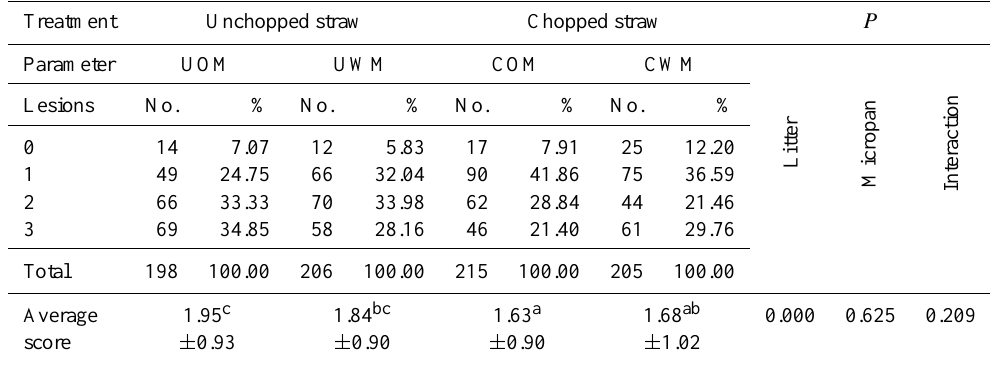
a − d Means within the same rows with different superscripts are significantly different ( P <0.05); COM: chopped straw without addition of Micropan; CWM: chopped straw with addition of Micropan; UOM: unchopped straw without addition of Micropan; UWM: unchopped straw with addition of Micropan. Table 4. Effect of straw size and litter amendment (Micropan) on the incidence of foot pad dermatitis (FPD) of broilers at 5 weeks of age ( ¯ x ± SD). Treatment